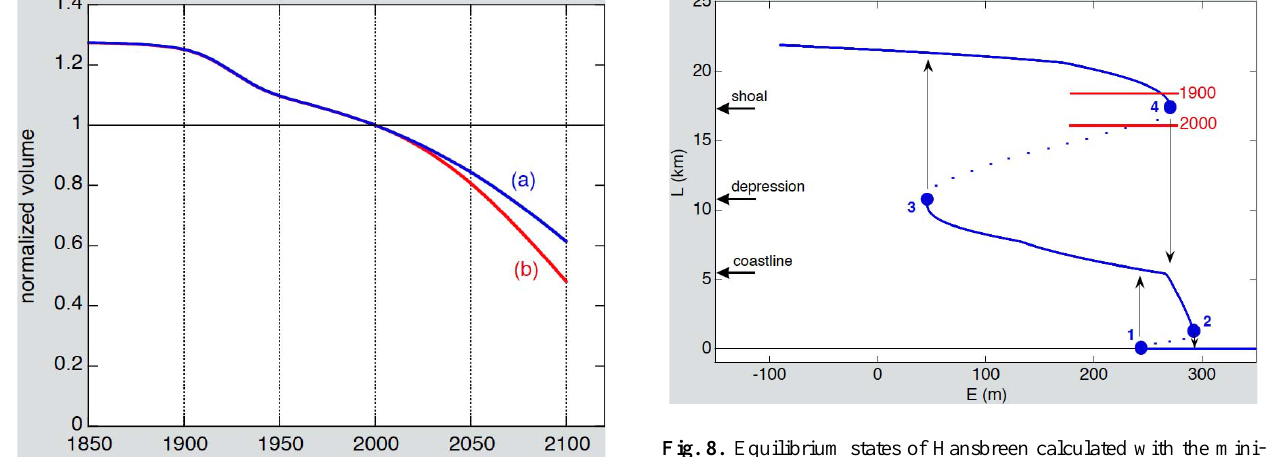
Fig. 8. Equilibrium states of Hansbreen calculated with the mini- mal model. The unstable equilibria are indicated by dotted lines. Arrows indicate the paths of the hystereses. Red bars give the ap- proximate positions of the terminus in the years indicated. Critical points are numbered as described in the